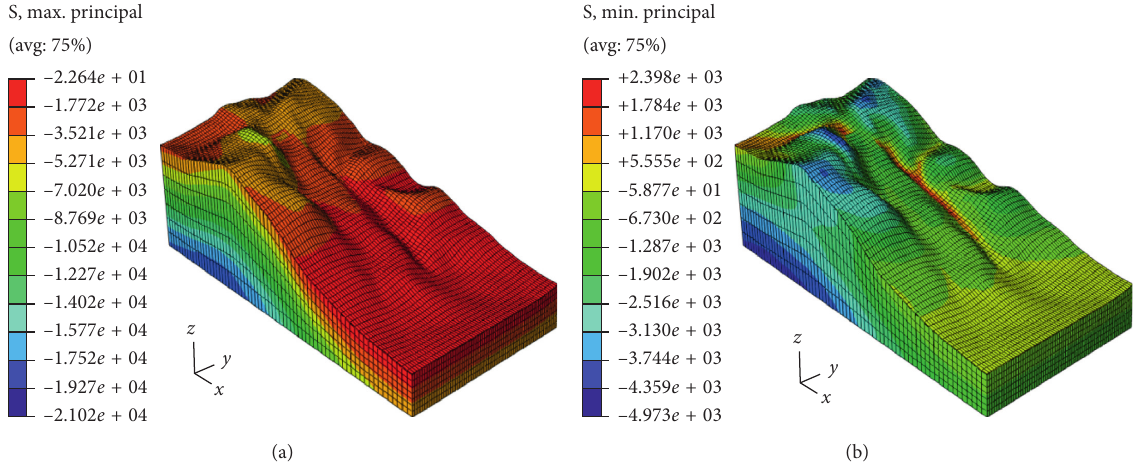
S, max. principal